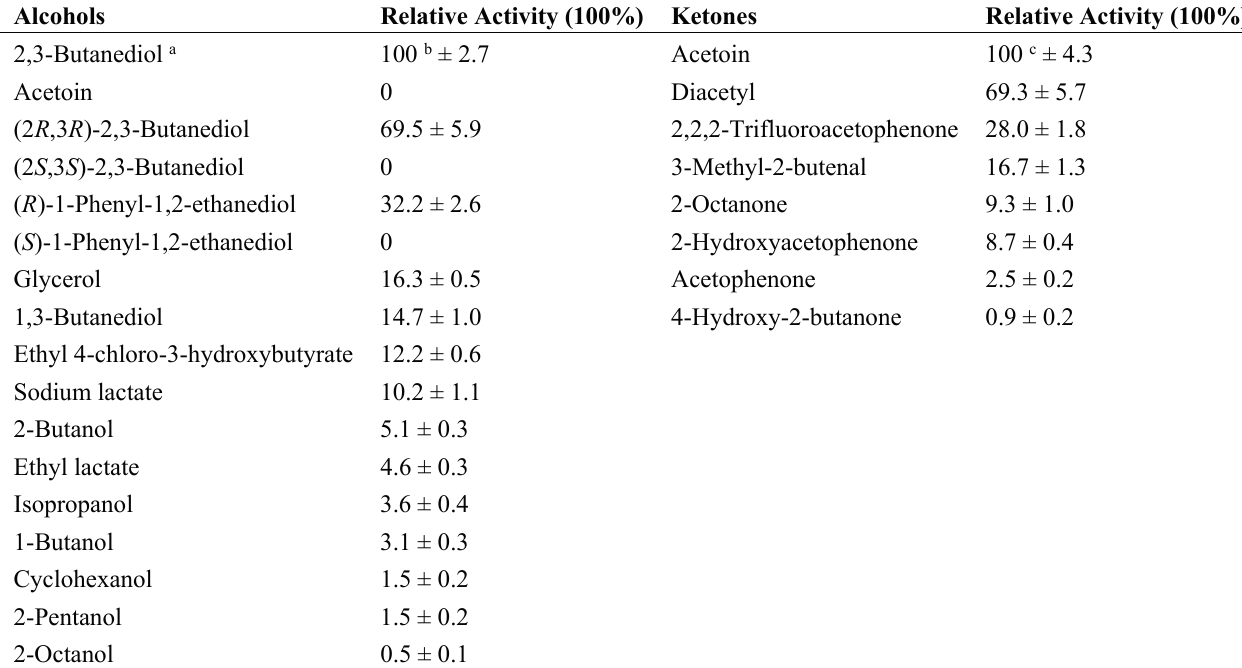
Table 1. Substrate specificity of ReBDH.